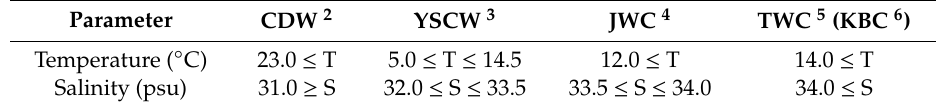
Table 1. Range of water temperature and salinity values by water mass in the NECS 1 .